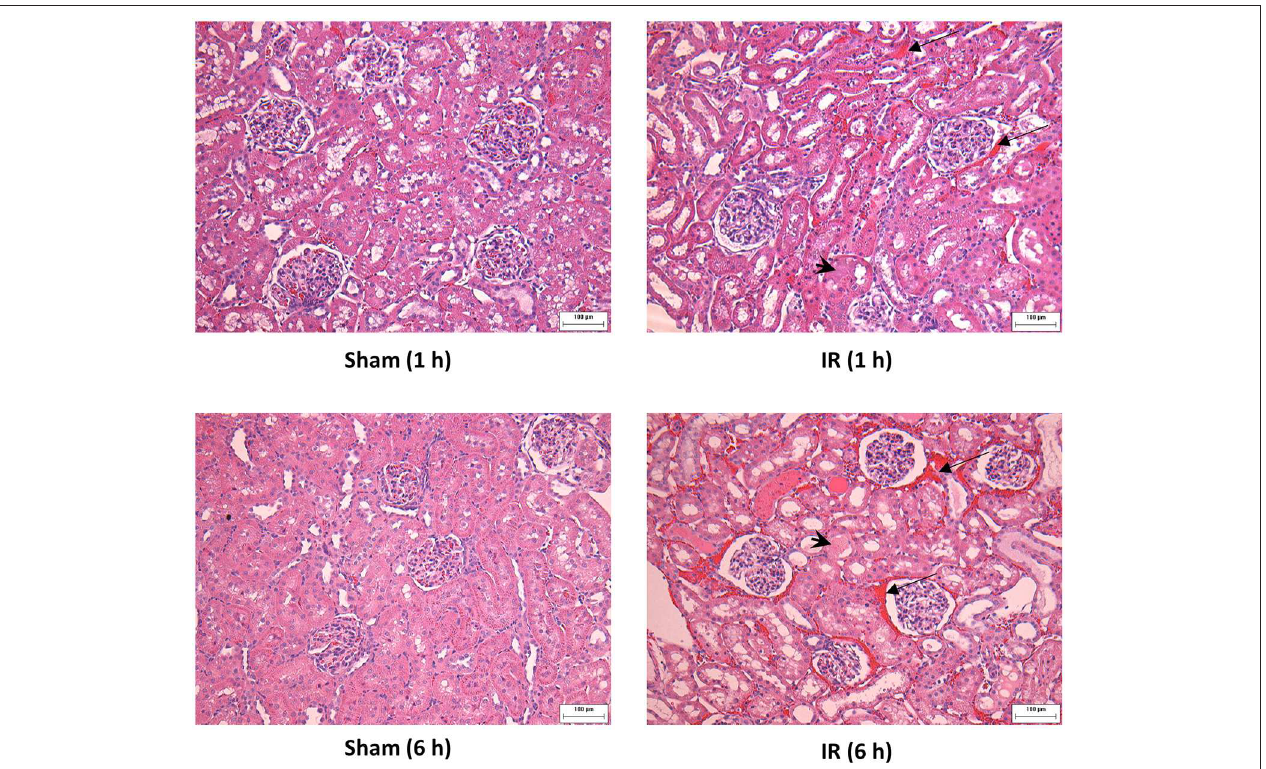
FIGURE 2 | Effect of kidney ischemia-reperfusion on histological change in the kidney. The left kidney of rats was subjected to 45min ischemia followed by 1 hour (1h) or 6 hours (6h) of reperfusion (IR). As a control, rats were subjected to a sham-operation without inducing ischemia (Sham). The histological structure of kidney was examined by hematoxylin and eosin (H&E) staining and analyzed at × 200 magnification. Kidneys of the IR group showed tubular necrosis (arrowheads), interstitial congestion of red blood cells (arrow), and glomerulus enlargement compared with the Sham group (scale bar = 100 µ m).